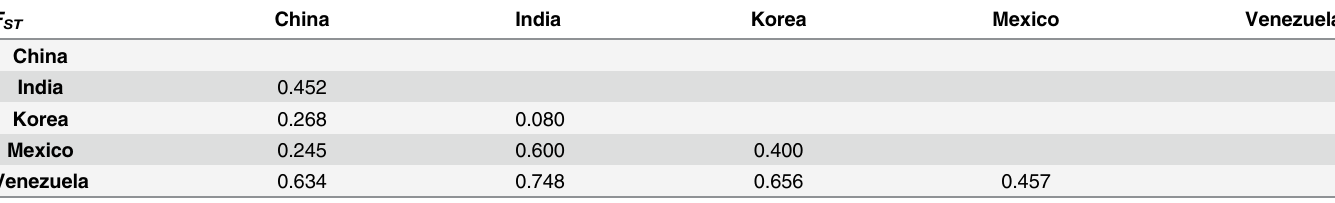
Table 6. Pairwise F ST indices of inter-population variance for the pvs25 gene. F